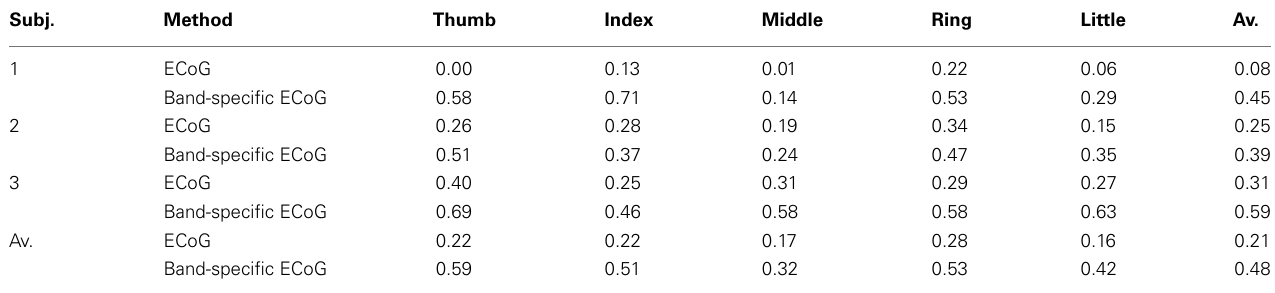
Table 1 |The prediction performance of the methods (with and without band-specific features) is provided in terms of correlation coefficient between the predicted and recorded finger movement for each finger and subject.